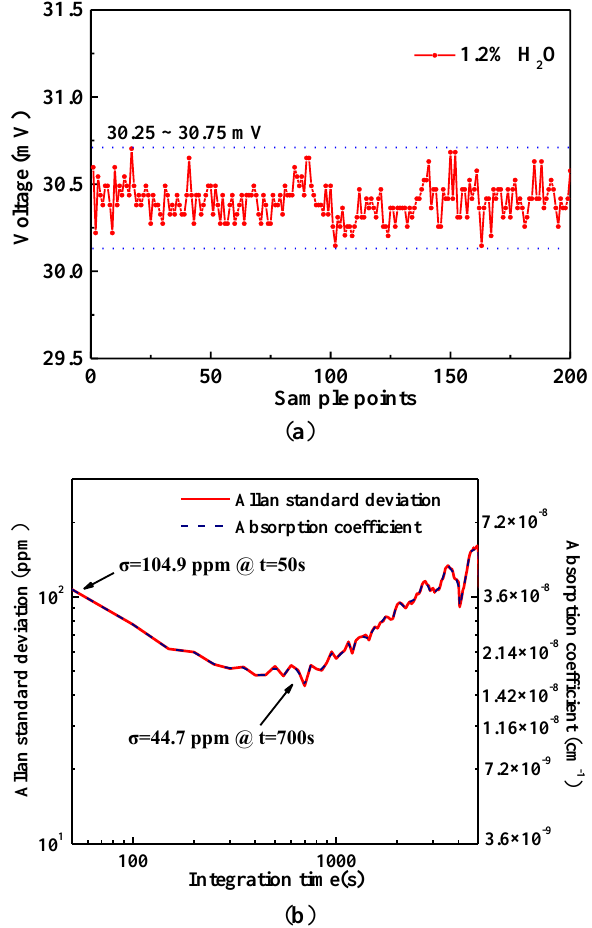
Figure 11. ( a ) Long-term monitoring of a standard 1.2% H 2 O sample. ( b ) Allan variance plot of the sensor system for the 1.2% H 2 O measurements.